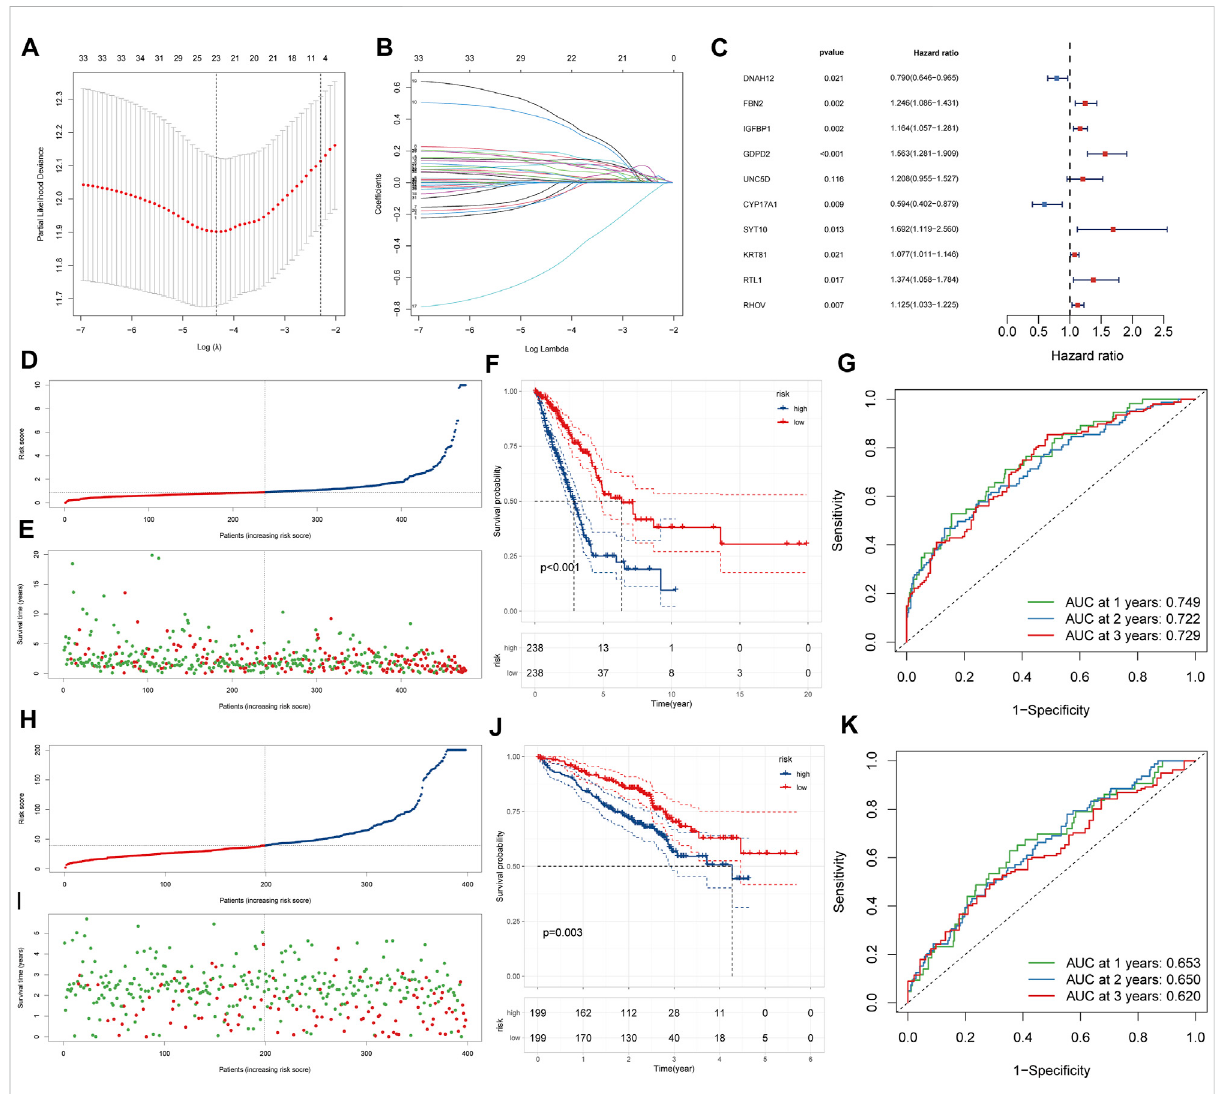
FIGURE 4 Construction and validation of LRPI (A) The change trajectory of the independent variable coef fi cient as the log lambda value increases (B) Change in misclassi fi cation probability as log lambda value changes (C) Multivariate cox analysis to validate the independent prognostic ability of model genes (D and E) LRPI score and survival outcomes of patients in the TCGA cohort (F) K-M survival curves of two LRPI subgroups of the TCGA cohort (G) 1-year, 2-years, and 3-years ROC curves and their area under the curve of LRPI in TCGA cohort (H and I) LRPI score and survival outcomes of patients in the GEO cohort (J) K-M survival curves of two LRPI subgroups of the TCGA cohort (K) 1-year, 2-years, and 3-years ROC curves and their area under the curve of LRPI in TCGA